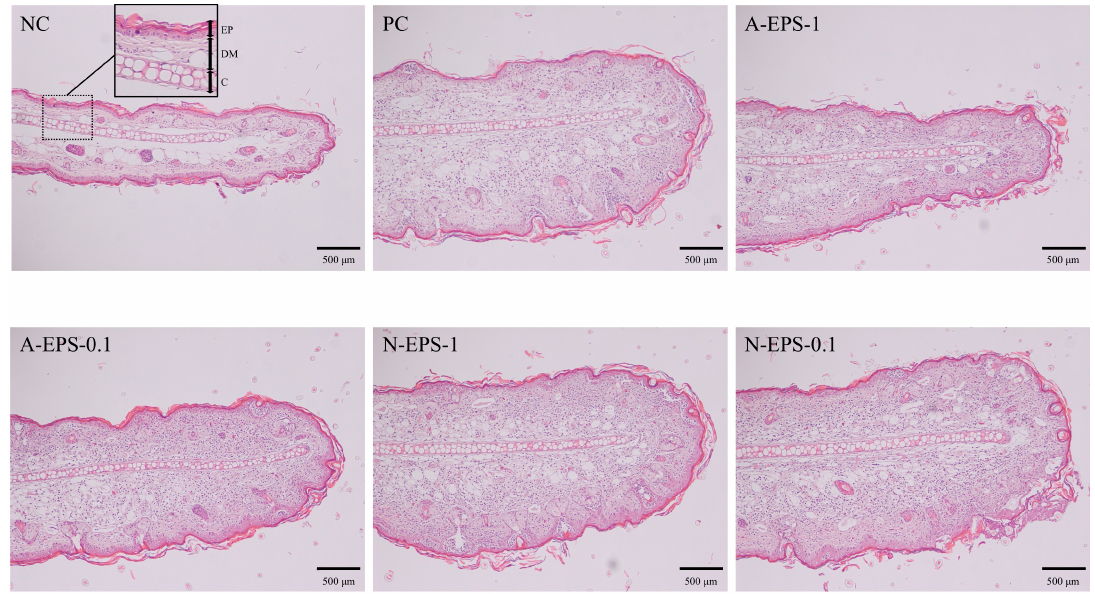
Figure 4. Effect of oral administration of IJH-SONE68-derived neutral and acidic EPSs to the ear lobe of PiCl-induced contact dermatitis mice. A representative tissue section of the ear lobe was stained with hematoxylin and eosin. Abbreviations used in the figure: NC, negative control (without inflammation); PC, positive control (without treatment); A-EPS-1, acidic EPS (1 mg/mL); A-EPS-0.1, acidic EPS (0.1 mg/mL); N-EPS-1, neutral EPS (1 mg/mL); N-EPS-0.1, neutral EPS (0.1 mg/mL); EP, epidermis layer; DM, dermis layer; C, cartilage. Scale bar = 500 μ m.